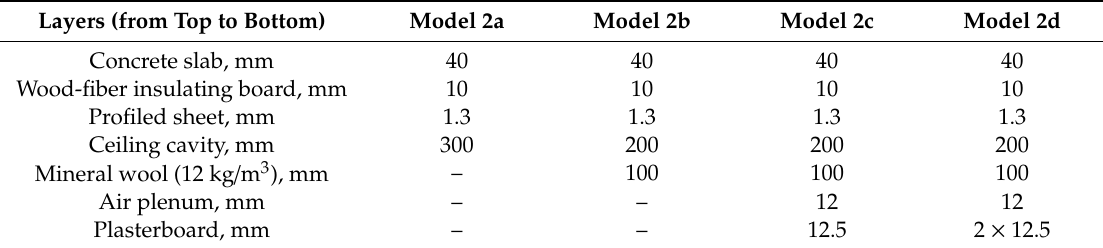
Mineral wool (12 kg / m 3 ), mm